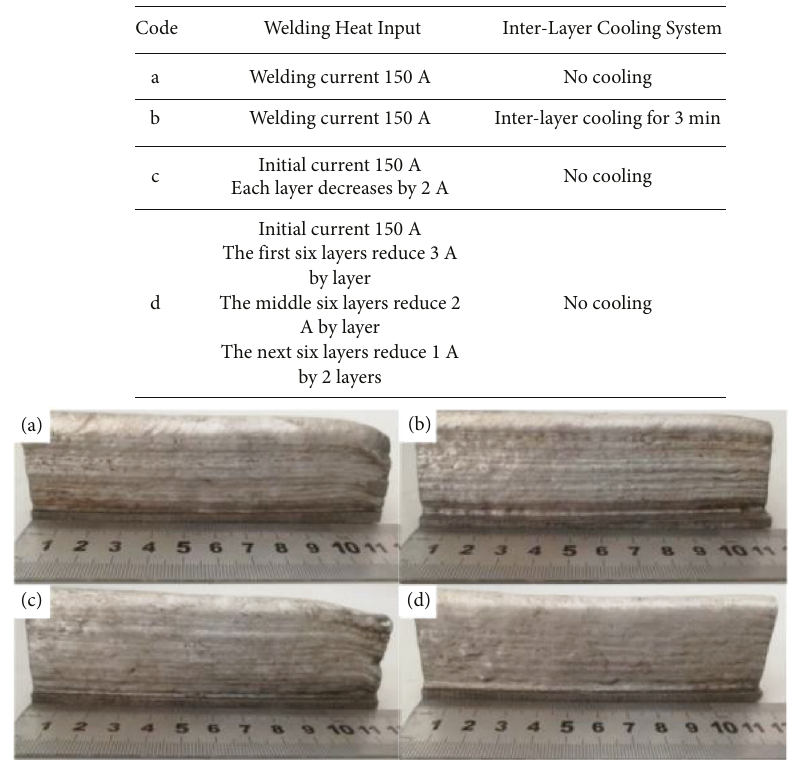
Figure 7: Process parameter table for changing heat input and interlayer cooling. Macromorphology of deposited specimens with different processing methods.